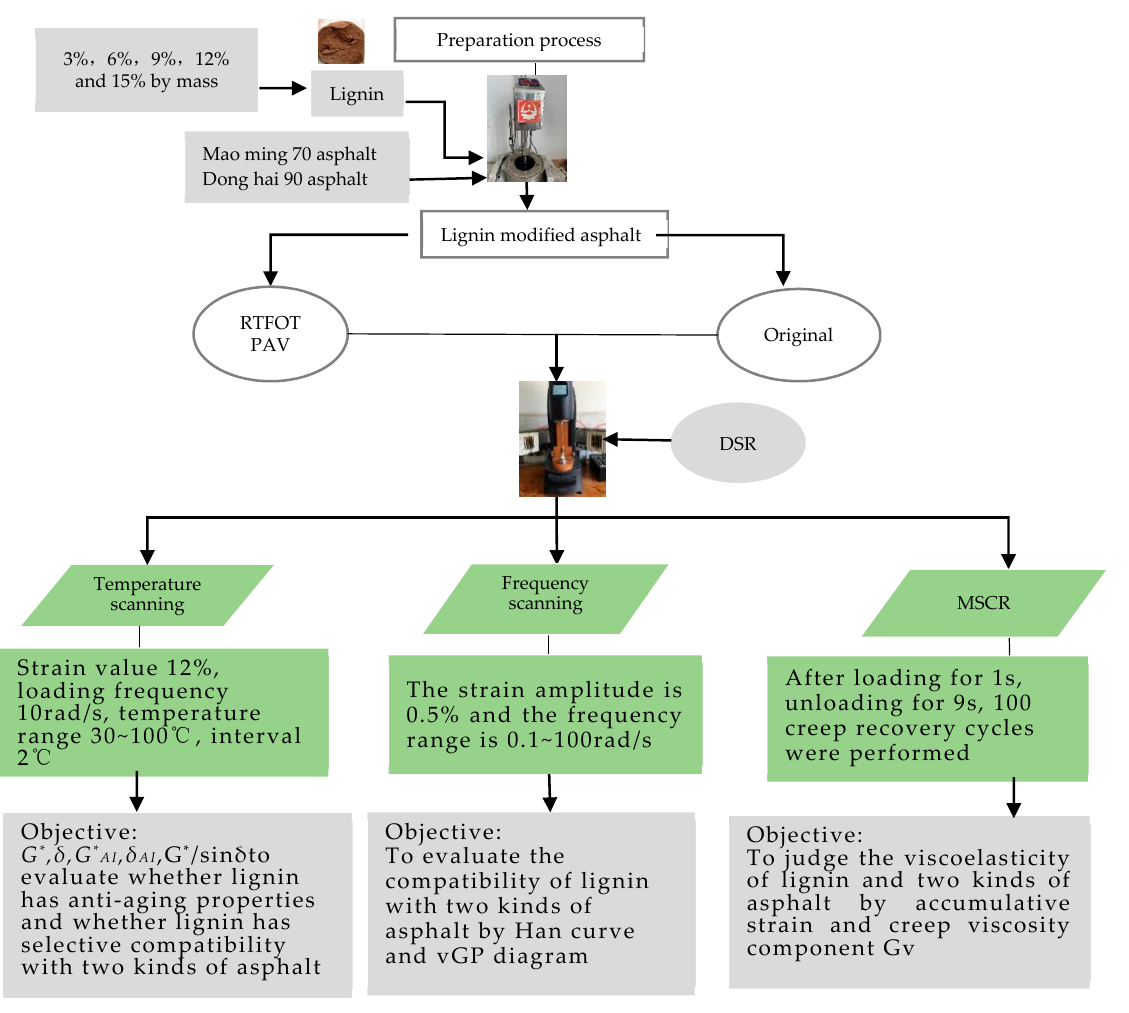
Figure 1. Experiment plan.